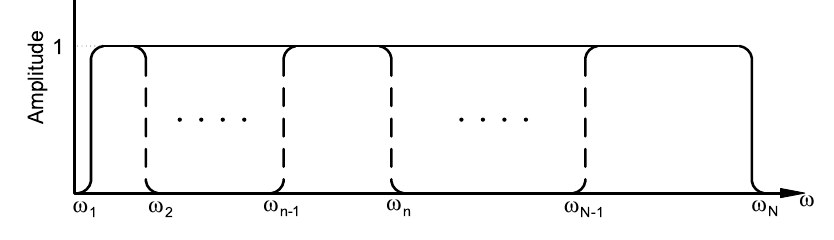
Fig. 2. Auto-spectrum of the random force.